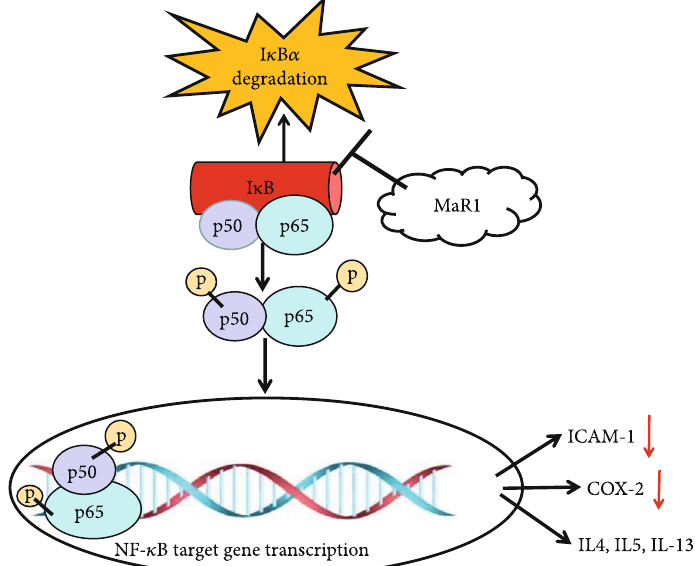
Figure 8: Model explaining the mechanism underlying the anti-in fl ammatory e ff ects of MaR1. MaR1 treatment decreased the levels of IL-4, IL-5, and IL-13 and inhibited COX-2 and ICAM-1 expression via the suppression of NF- κ B signaling in the OVA-induced asthma mouse model. MaR1 is a potential anti-in fl ammatory compound that could ameliorate in fl ammation in the OVA-induced asthma mouse